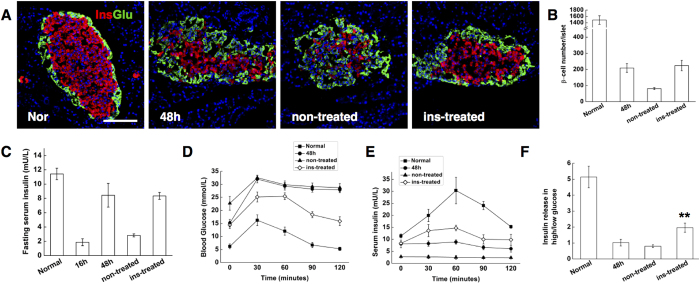
Neogenic beta-cells survived and acquired functionality after insulin treatment.(A) Representative islets stained with antibodies against insulin (red) and glucagon (green) of normal control SD rats (Nor), STZ-treated rats after 48 hrs (48 h), ins-treated rats after 7 days’ insulin treatment with a one-day washout (insulin-treated), and concurrent non-treated control rats (non-treated). Nuclei were labeled with DAPI. Scale bars, 100 μm. (B) Quantification of beta-cell number. (C) Fasting serum insulin levels in normal control SD rats (Nor), STZ-treated rats after 16 and 48 hrs (16 h, 48 h), insulin-treated rats by day 7 (insulin-treated) and concurrent non-treated control rats (non-treated). (D and E) Plasma glucose and insulin during an IP-GTT. (F) GSIS in vitro, measured as the ratio of insulin release in high glucose to insulin release in low glucose. Data are shown as means ± SEM, n = 6 rats per group; **P < 0.01.